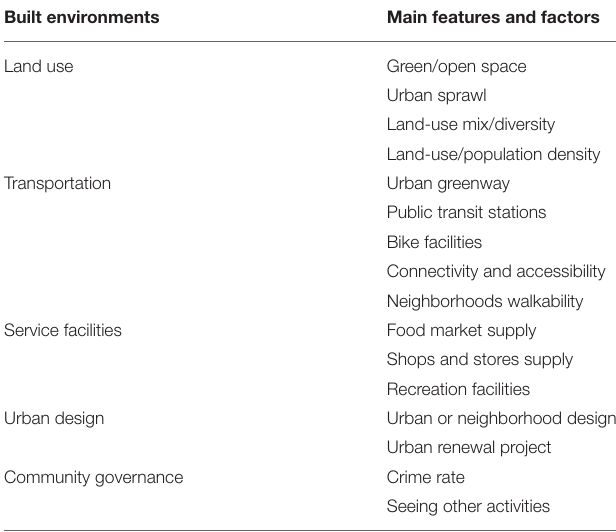
TABLE 1 | Components and features of the built